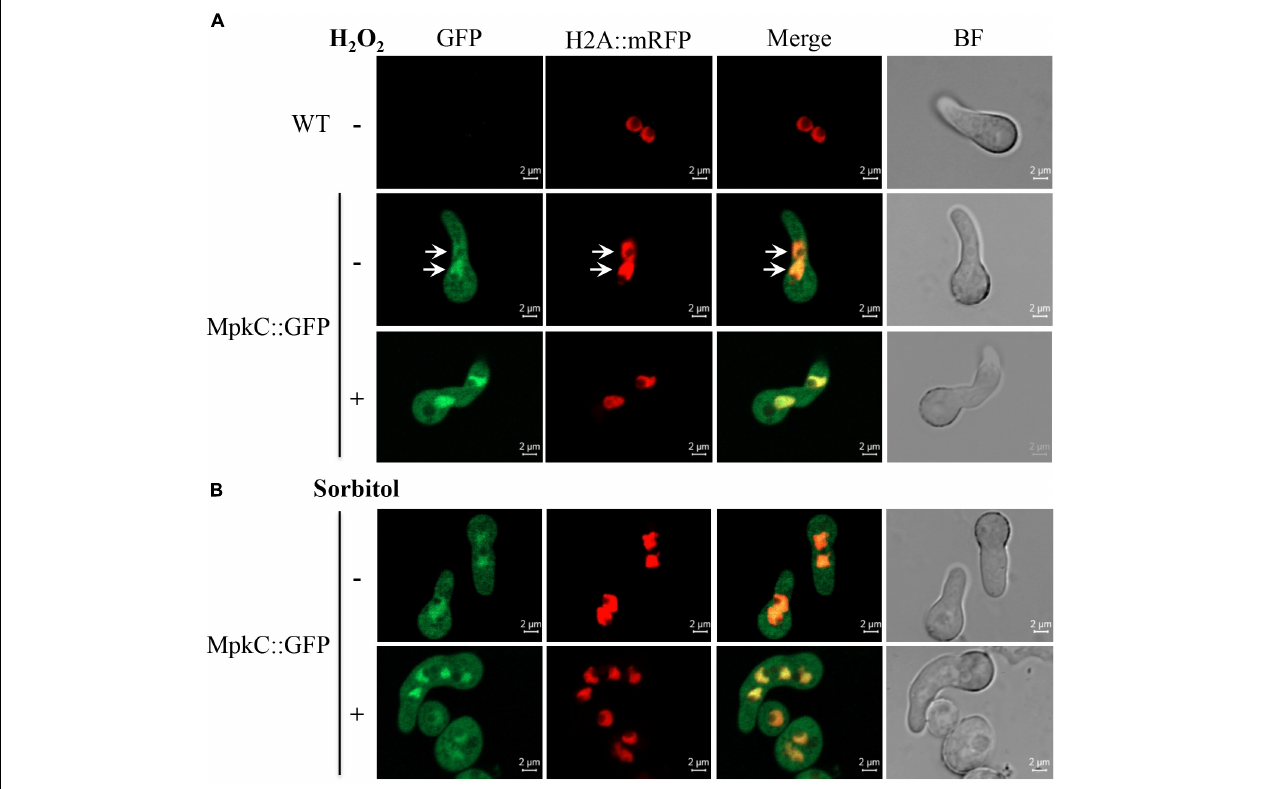
FIGURE 5 | Oxidative and osmotic stresses increase the nuclear accumulation of MpkC during spore germination. (A) Conidia from strains TRJ7 (WT H2A::mRFP) and TRJ13 (MpkC::GFP H2A::mRFP) were germinated for 6 h in minimal medium (Top), treated or not with 10 mM H 2 O 2 for 10 min and then observed using confocal microscopy. (B) Conidia from strain TRJ13 (MpkC::GFP H2A::mRFP) were germinated for 6 h in MM containing or lacking 1.2 M sorbitol and observed using confocal microscopy. Arrows in panel (A) point to nuclear signal.